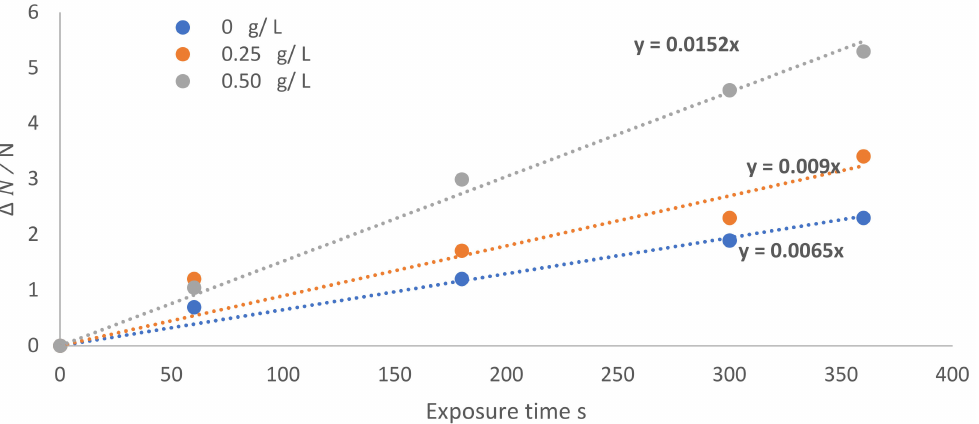
Figure 8. ∆ N / N as a function of exposure time at different TiO 2 concentrations, 0, 0.25, and 0.50 g/L, 0 coupled with dry argon APPJ